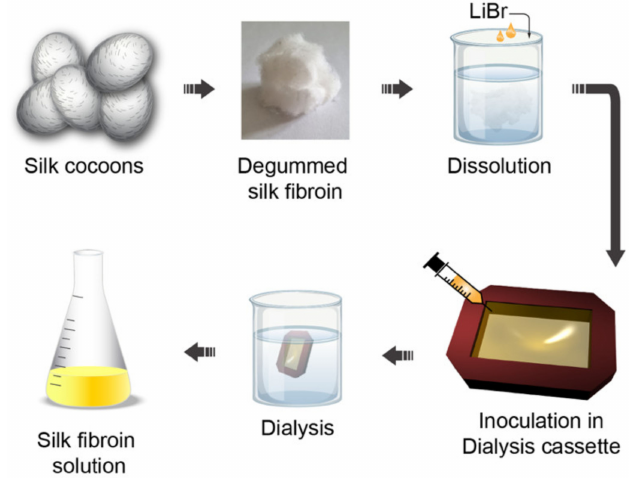
Figure 4. Silk fibroin water solution fabrication : Silk cocoons are degummed through a boiling process and dissolved in a LiBr salt solution. The obtained solution is inoculated in a dialysis cassette and dialyzed for 48 h in ultrapure water. After that, the dialyzed solution is stirred to obtain the silk fibroin in aqueous solution. Inspired by references [83,84].